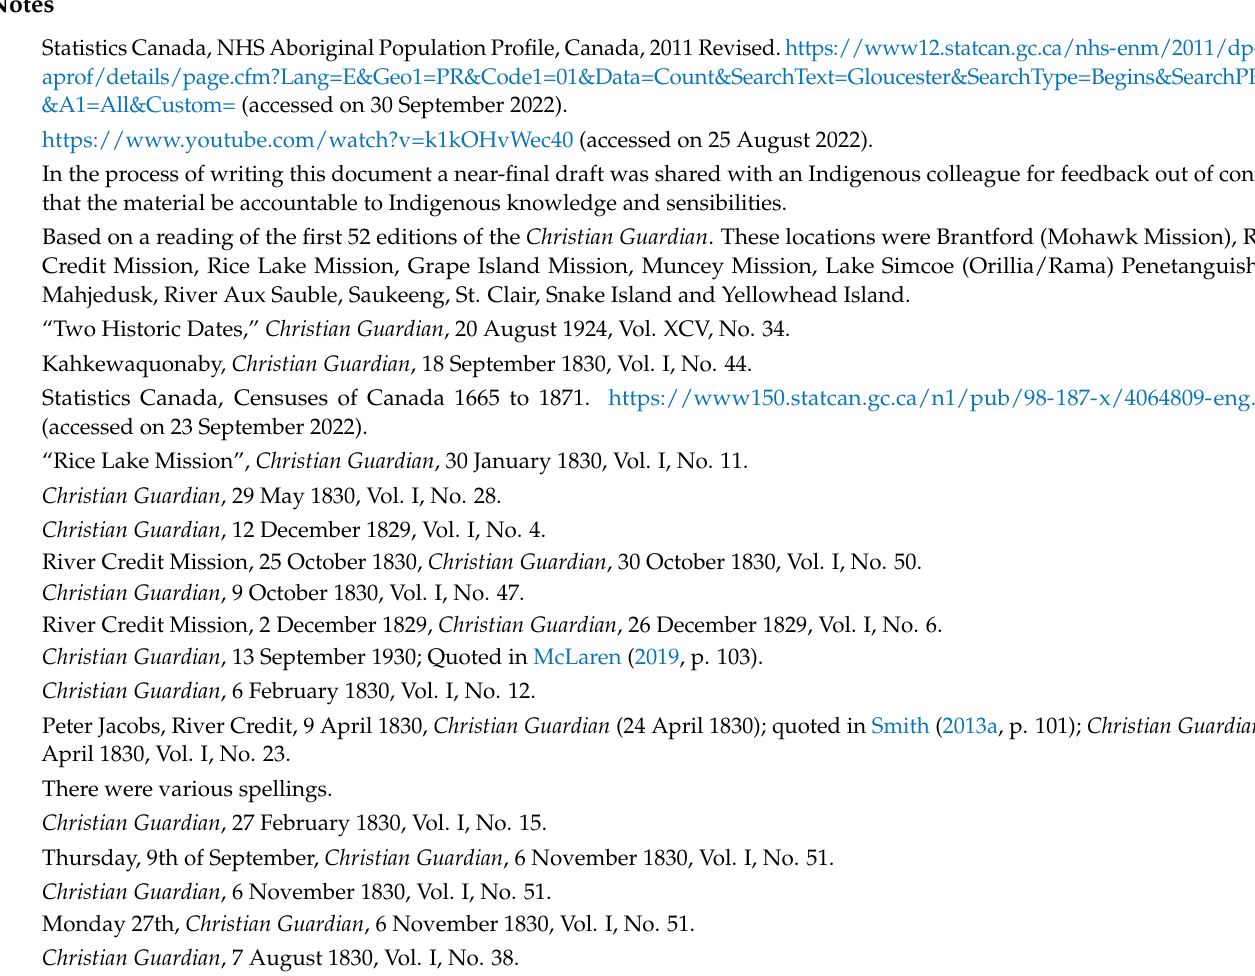
In the process of writing this document a near-final draft was shared with an Indigenous colleague for feedback out of concern that the material be accountable to Indigenous knowledge and